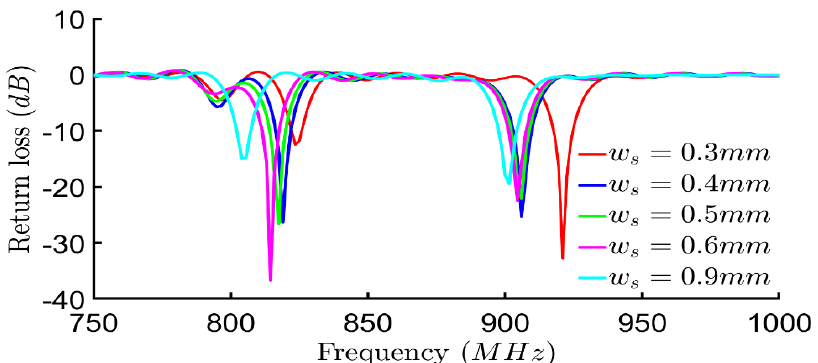
Figure 11. The return loss of the proposed structure with different stub width.